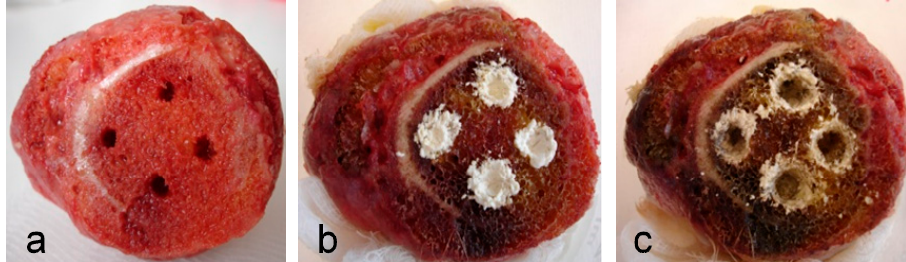
Figure 1. Femur head ( a ) with drilled holes infected with bacteria; ( b ) filled with a peptide blended with local carrier (ChronOS Inject), local carrier alone, and local carrier loaded with antibiotic; ( c ) after removal of the fillings (representative example).